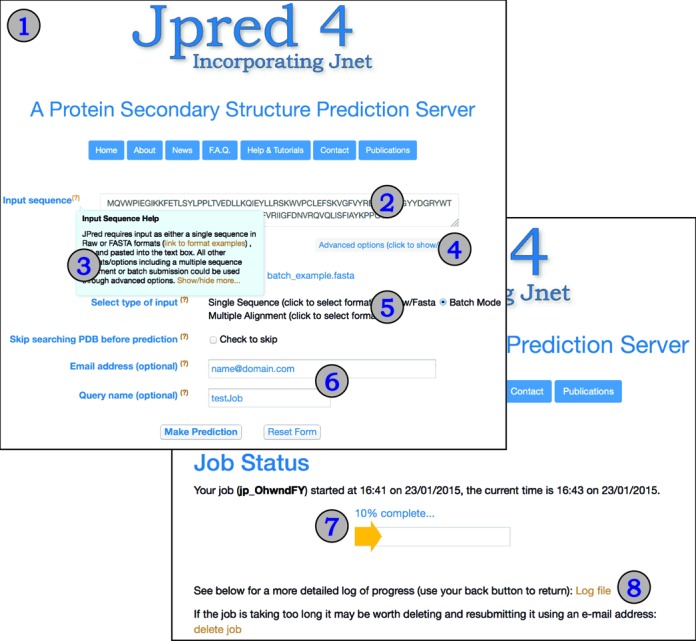
(1) Screenshot of the JPred4 job submission page with single sequence submission field (2) and an example of a tool-tip message (3). Advanced options are opened on request (4) and include input file upload, format selection (5) as well as optional email and query name fields (6). (7) Job progress page with access to the detailed job run log file (8).